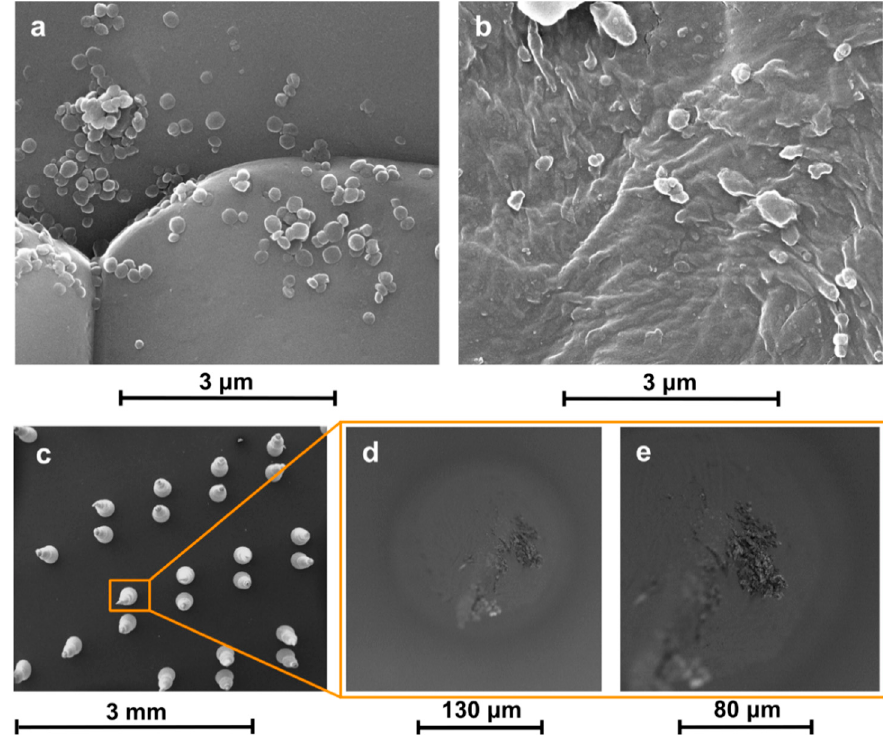
Figure 2. SEM micrographs of NC-TEO deposited via MAPLE on KBr ( a ), PE ( b ), and acrylate microneedles ( c – e ).